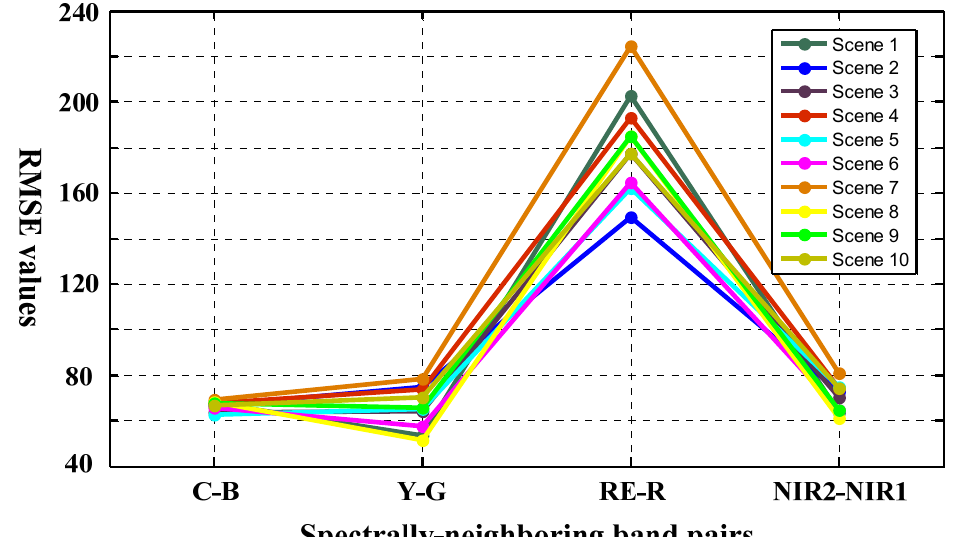
Figure 12. Quantitative analysis of spectral differences of the WorldView-2